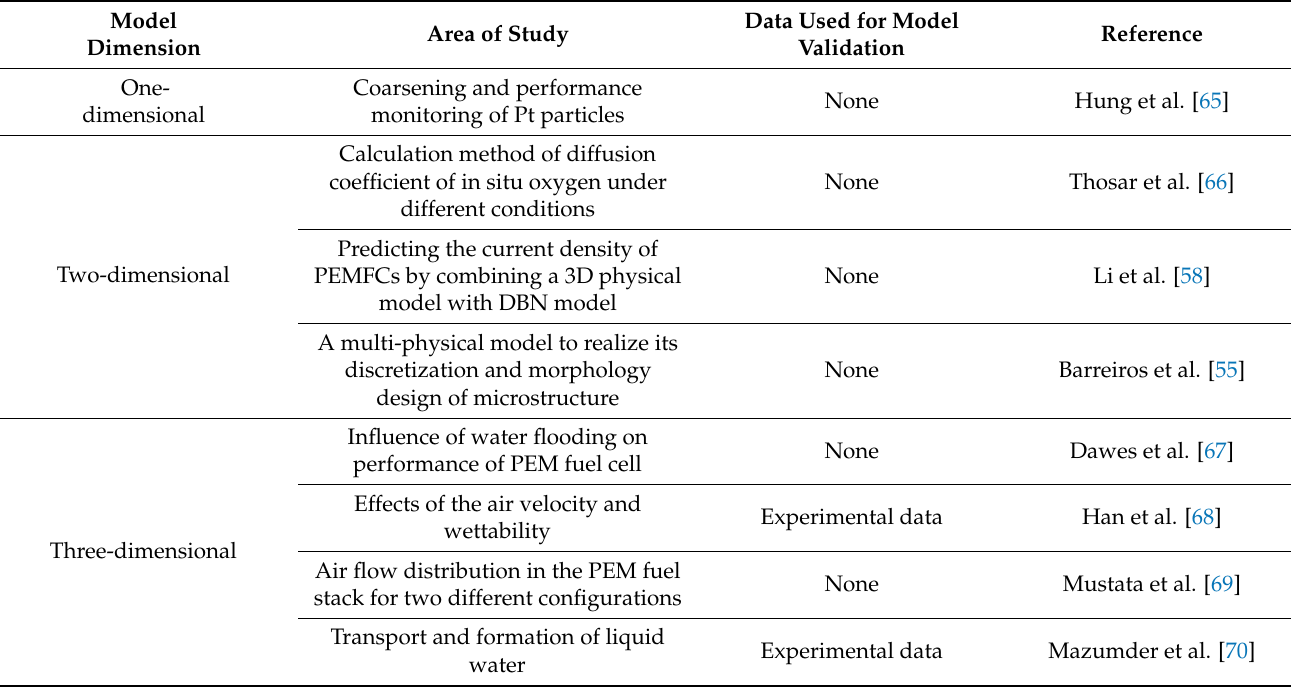
Table 2. Summary of CL